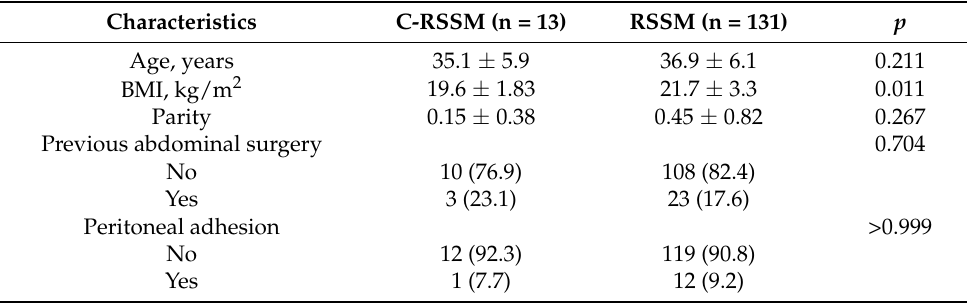
Table 1. Baseline characteristics of myomectomy